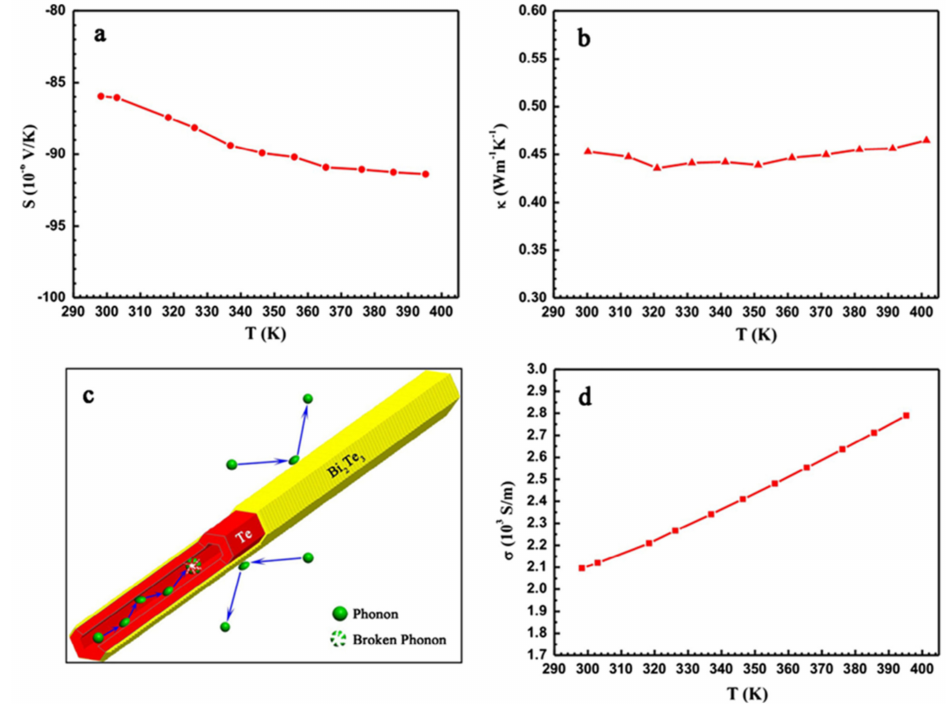
Figure 12. ( a ) Seebeck coefficient and ( b ) Thermal conductivities of the Te/Bi 2 Te 3 core/shell het- erostructure NTs depending on the temperature; ( c ) Mechanism of phonon scattering in the center or on the surface of the NTs; ( d ) Electrical conductivities based on temperature. Reprinted with permission from [56]. Copyright 2014, Elsevier Ltd., Amsterdam, The